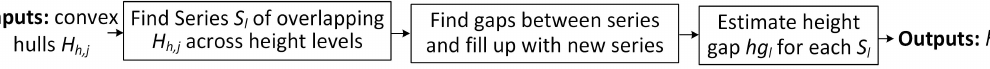
Figure 5. The work flow for estimating the height